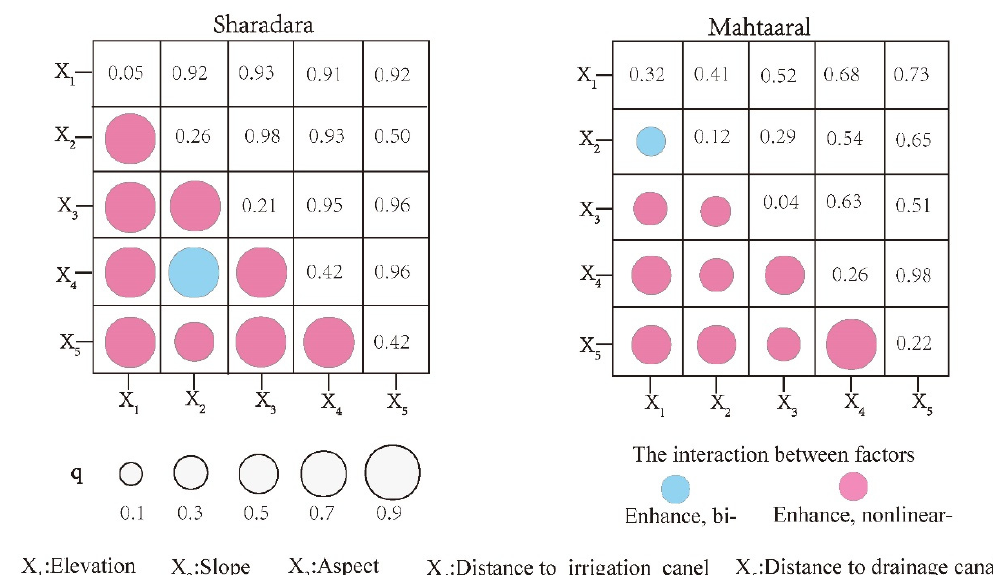
Figure 10. Two ‐ factor explanatory power of the interactions between different influencing factors on soil salinity.